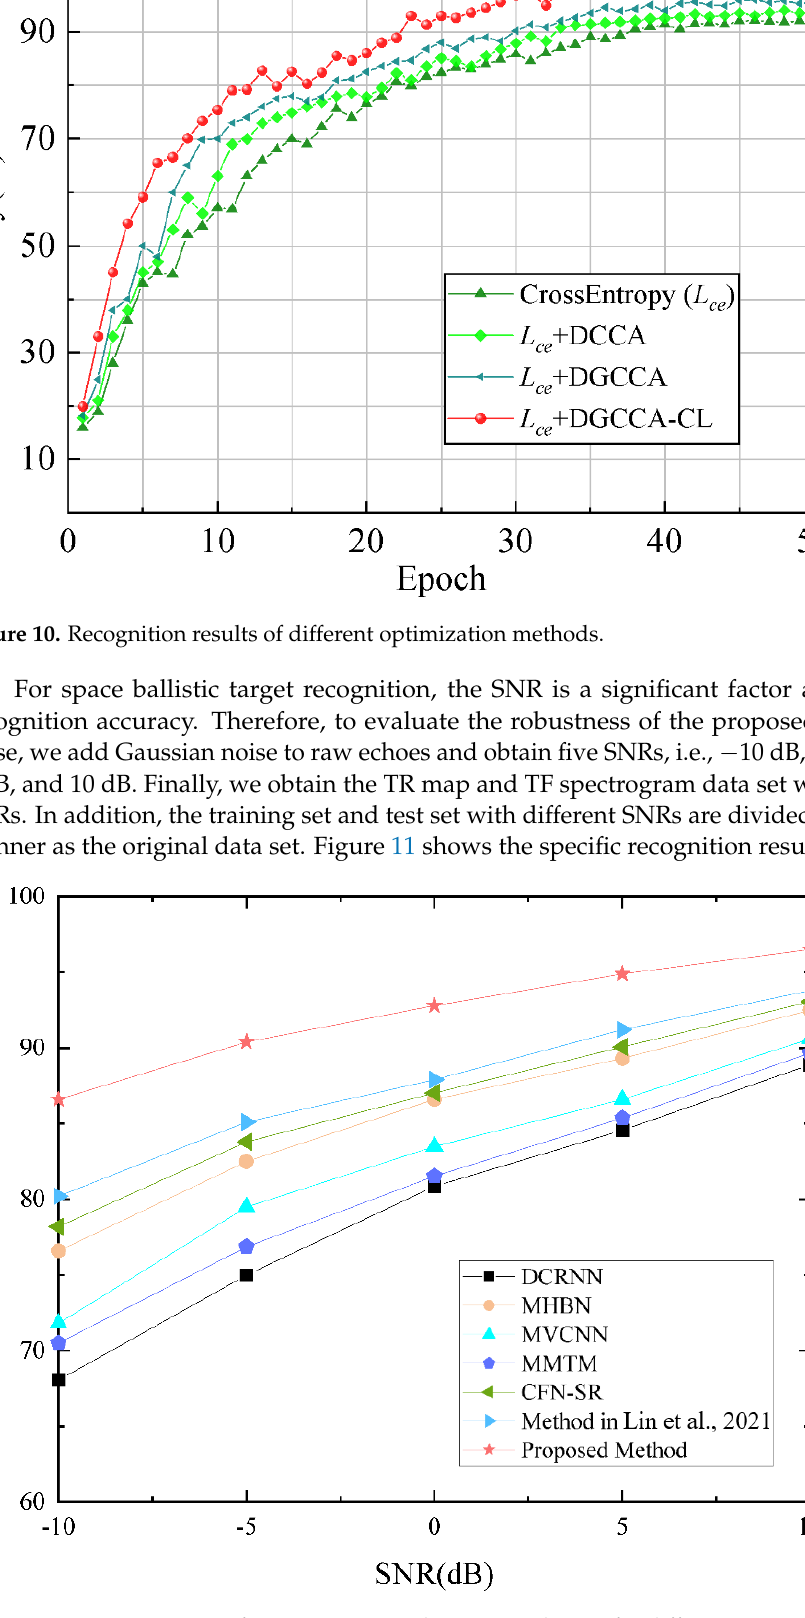
Figure 11. Variation curve of recognition rate changing with SNR for different networks.